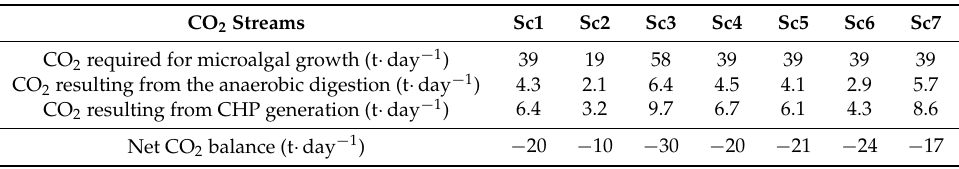
Table 4. Net CO 2 balance in each of the studied scenarios